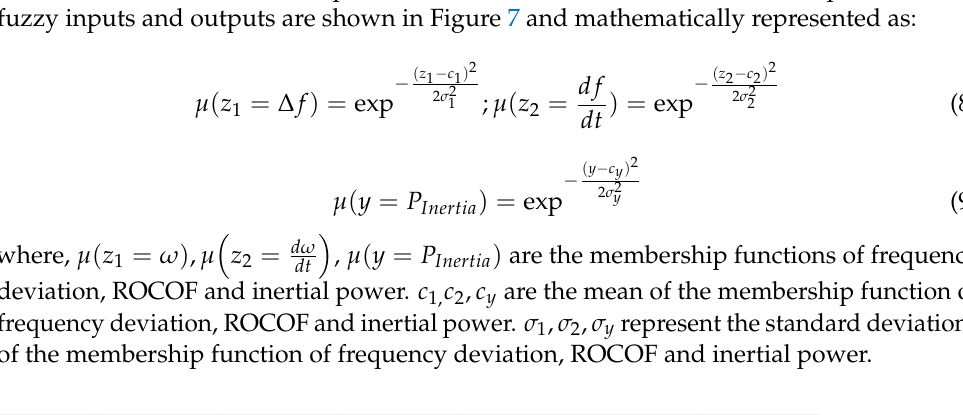
. Figure 7. Membership function of ( a ) frequency deviation; ( b ) ROCOF; ( c ) Inertial power. Initially, fuzzification is utilized to transform actual inputs into fuzzy values. Table 2 summarizes the properties of input and output membership functions. The mean of the membership is defined as the range of inputs/outputs to several partitions (number of partitions = number of membership functions − 1).